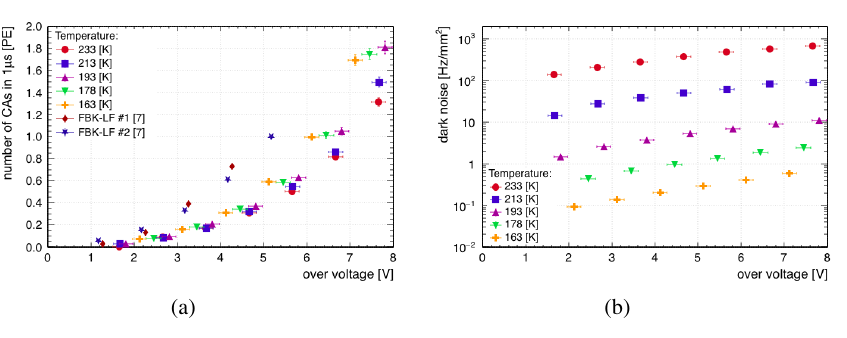
Figure 1: a) Number of Correlated Avalanches (CAs) per primary pulse within a time window of 1 μ s after the trigger pulse. b) Dark Noise (DN) rate normalized by the SiPM photon sensitive